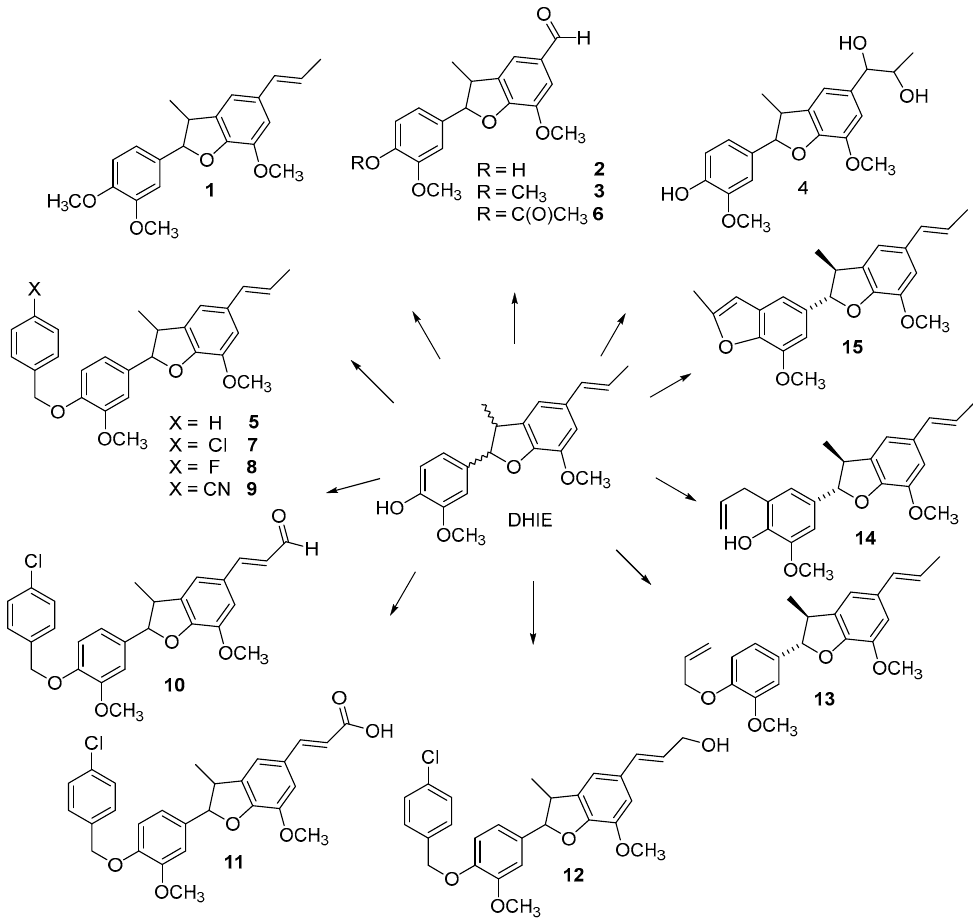
Figure 4. Semi-synthetic derivatives of DHIE.